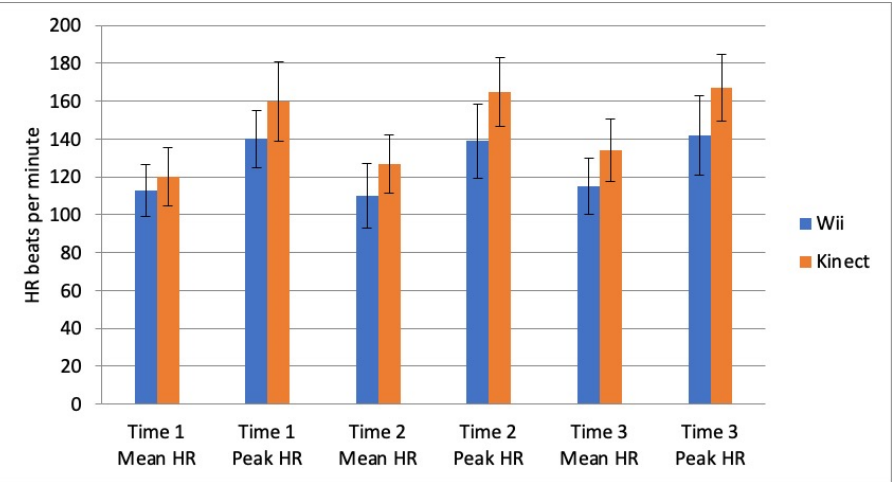
Figure 4. Mean and Peak Heart Rate (HR) recorded in the children in the first, third and fifth week of training on the Wii or Kinect.